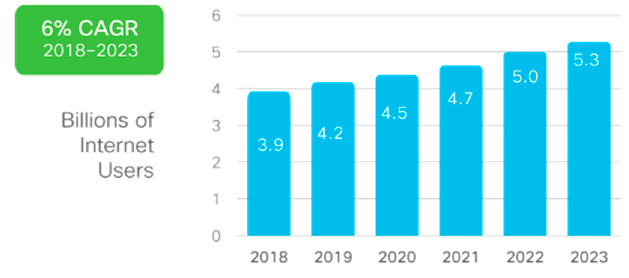
Figure 1. Growth Projection in Internet Users from 2018 to 2023 [1].